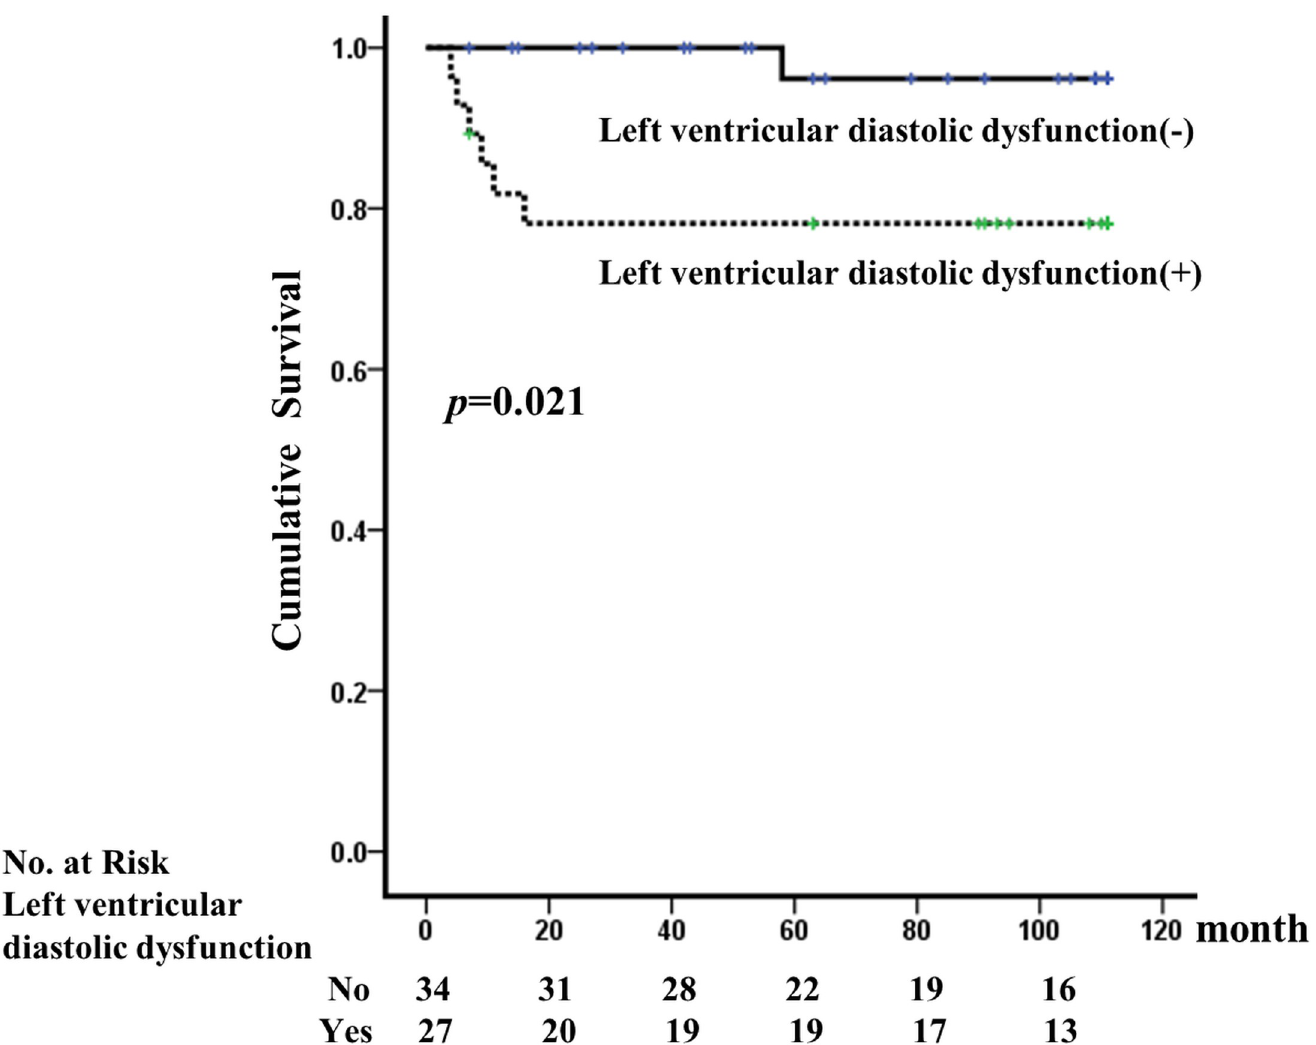
Fig 1. Kaplan-Meier survival curves for CV mortality according to LV diastolic dysfunction. CV mortality was significantly higher in patients with LV diastolic dysfunction (log-rank test, p = 0.021).